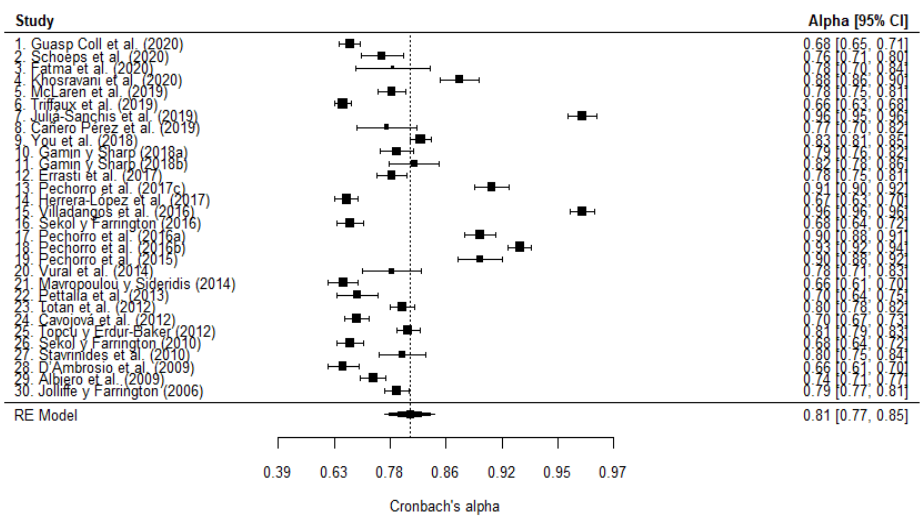
Figure 4. Forest plot of the cognitive empathy meta-analysis.